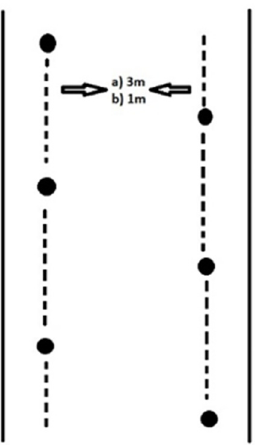
Figure 1. ( a ) Preview of IS turn; ( b ) preview of AS turn.